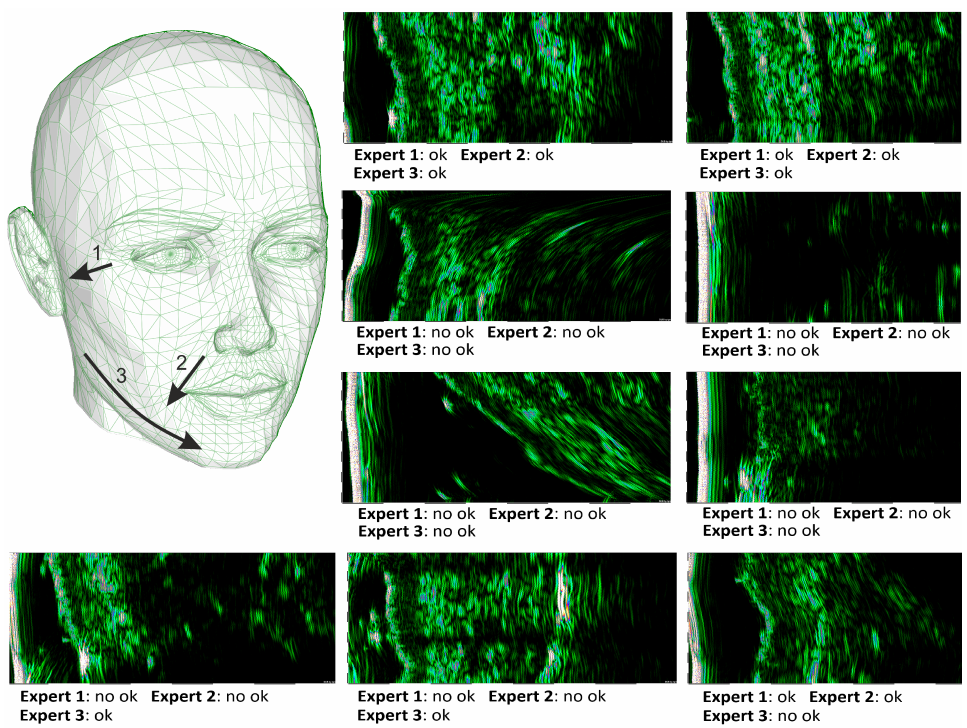
Figure 1. Facial model with superimposed image acquisition areas, and exemplary HFUS images, annotated by the